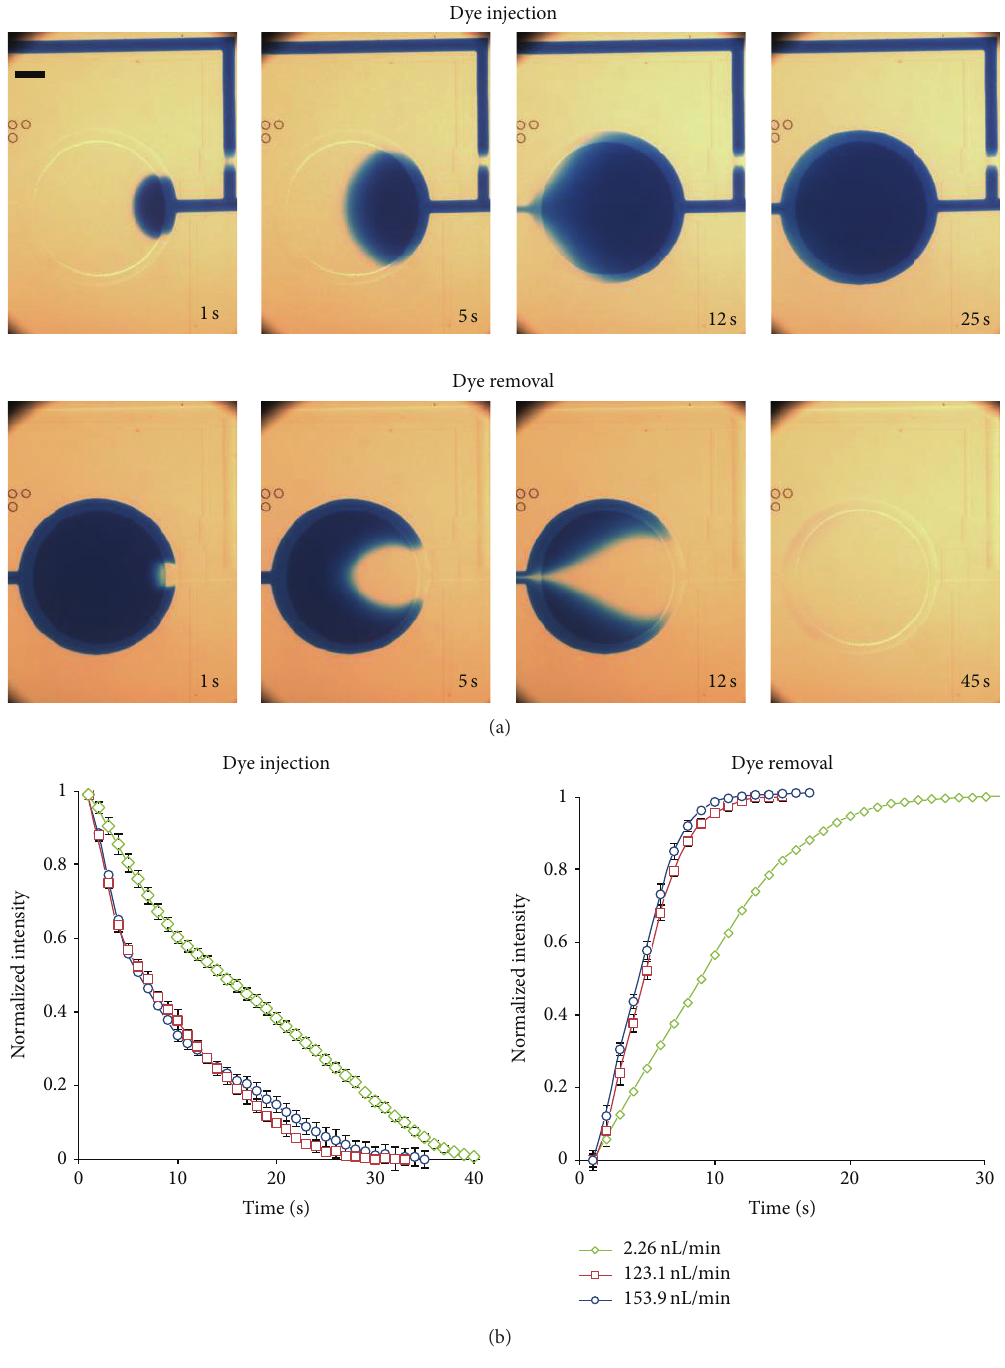
Figure 3: (a) Representative snapshots of dye injection ( upper row) and dye extraction ( lower row) processes at 1s, 5s, and 12s ( left to right ) under a flow rate of 24.6 nL/min. Scale bar: 250 𝜇 m. (b) Normalized average color intensities in the chamber for flow rates 24.6 nL/min, 123.1 nL/min, and 153.9 nL/min during the dye injection ( left ) and dye extraction ( right ) processes. All of the curves of the color intensities were obtained by at least three independent experiments. Error bars represent the standard